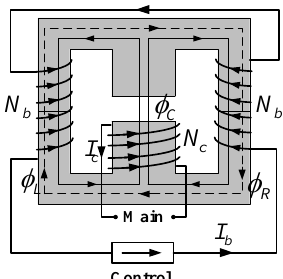
Figure 1. Variable inductor based on a double E-core